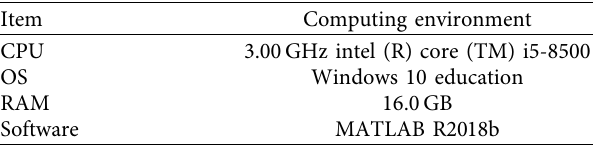
Table 2: Experimental environment of the